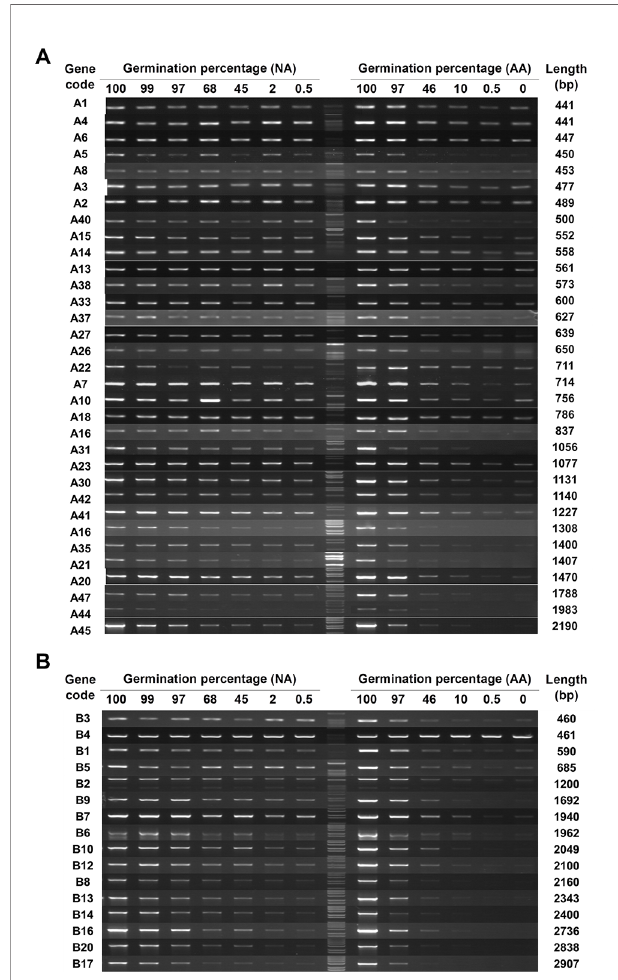
FIGURE 1 | The level of stored mRNAs in naturally aged (NA) and arti fi cially aged (AA) Arabidopsis seeds detected by RT-PCR. cDNAs from NA and AA seeds with different percentages of germination as well as the control seeds (100% germination) were used. Different genes in two groups were analyzed. The number of PCR cycles varied depending on their mRNA abundance in the unaged seeds. PCR products were run in agarose gels. (A) Analysis of 33 genes in group A (see Table S2 for the list of genes). (B) Analysis of 16 genes in group B. The germination percentage of a seed sample is indicated above the DNA lane. M stands for the 1 kb DNA molecular ladder. The gene code is indicated at the left and the cDNA length ampli fi ed by PCR indicated at the right of each